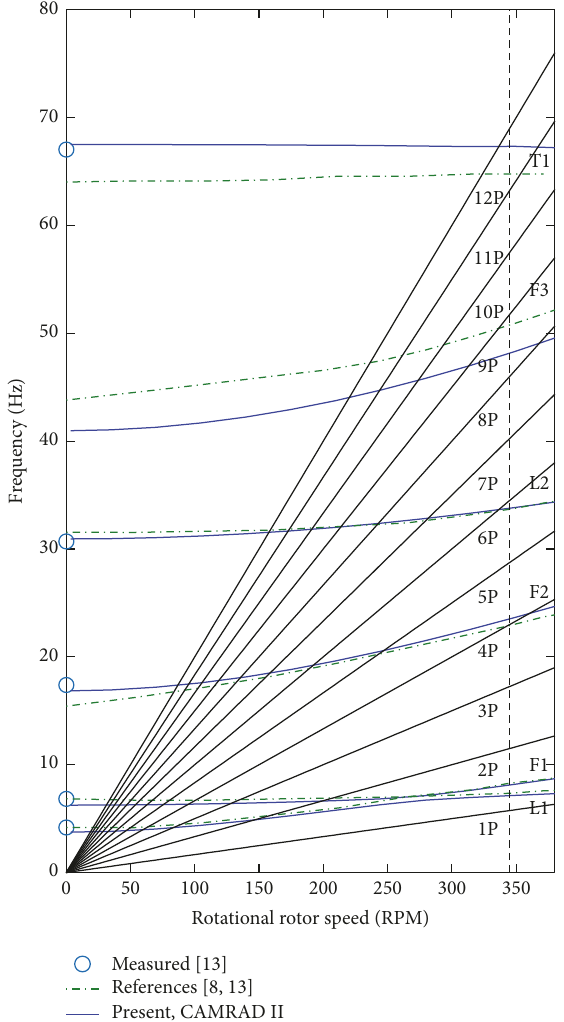
Figure 8: Validation of the natural frequency (L: lead-lag mode, F: flap mode, T: torsional mode, and P: per